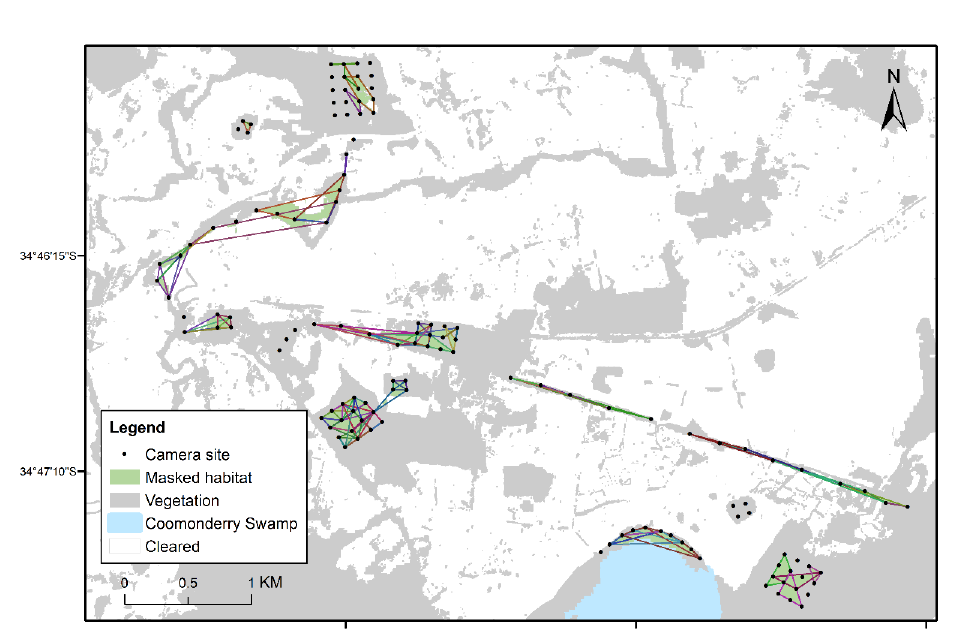
Figure 5. Polygons formed by connected sites for 20 brown antechinus ( Antechinus stuartii ) where individuals (females = 9, males = 11) were observed on at least two selfie trap sites. Useable habitat within polygons (masked habitat) is highlighted in green. 3.3. Movements within and between Fragments of Habitat Across 121 sugar gliders, the amount of useable habitat within MCPs for an individ- ual ranged from 3.1 ha to 5.2 ha (Figure 4). Gliders were detected in all sampled fragments